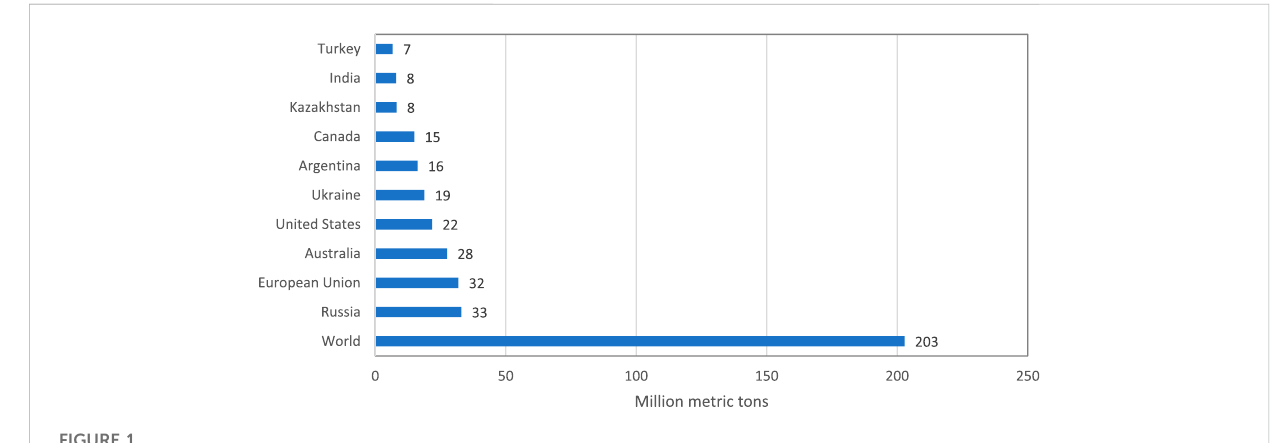
FIGURE 1 Top 10 wheat exporting countries in 2021/22. Source: Authors based on USDA